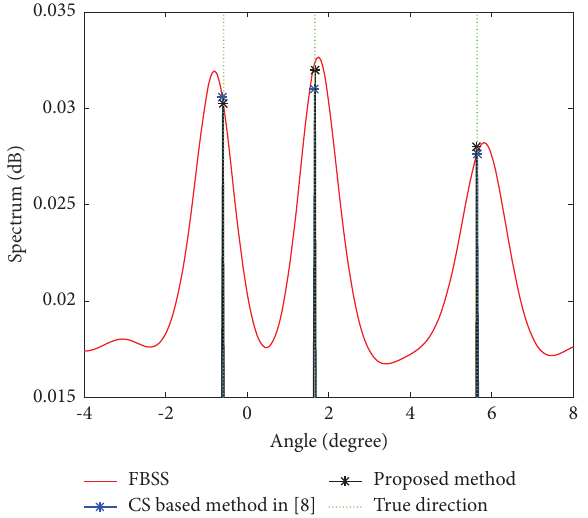
Figure 2: Te DOA estimation RMSE vs SNR